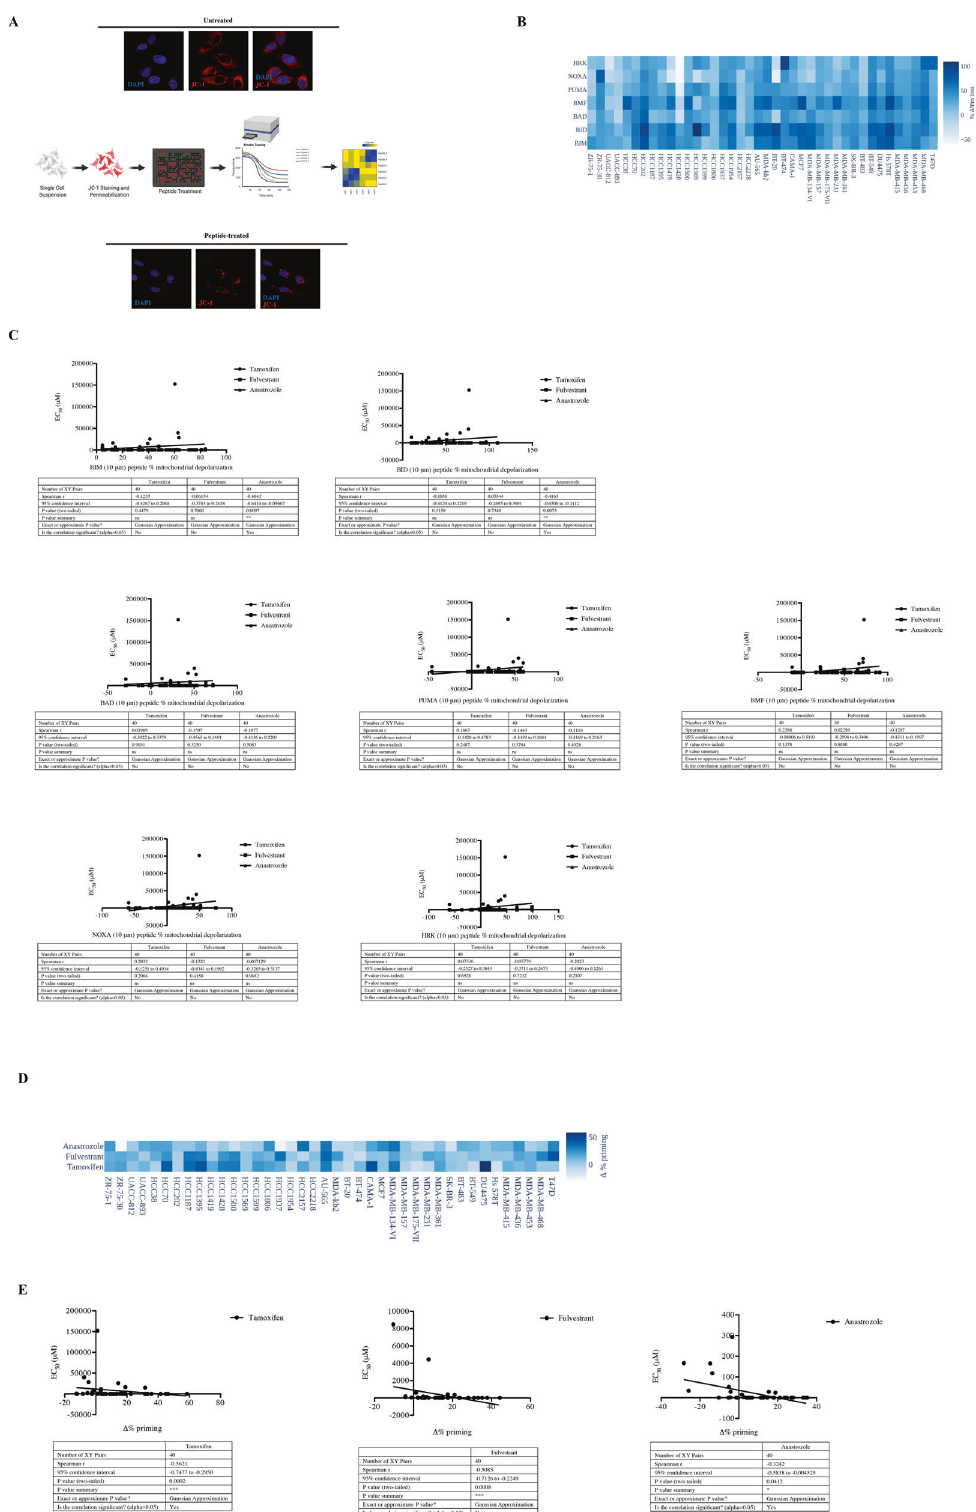
BH3 Pro fi ling of breast cancer cell lines and normal breast epithelial cell lines reveals distinct patterns of dependence on anti-apoptotic Bcl-2 proteins BH3 and dynamic BH3 pro fi ling assays functionally evaluate mitochondrial priming, which indicates the closeness to the